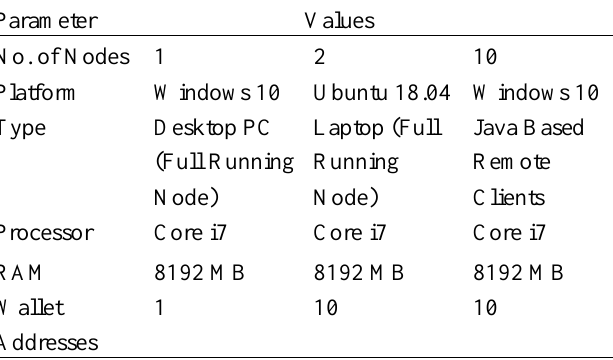
Node specifications for MultiChain 2.0